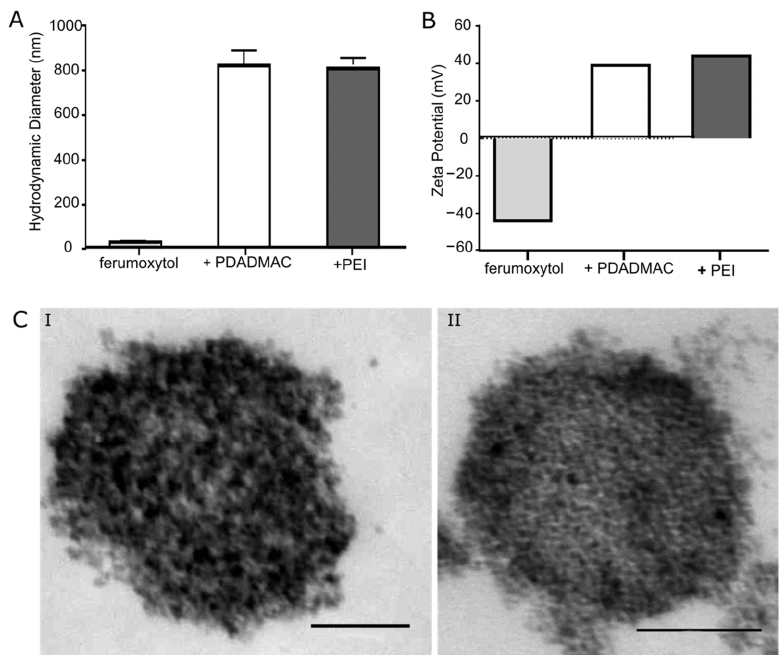
Figure 1. Characterization of uncoated, PDADMAC-, and PEI-coated ferumoxytol MNPs. ( A ) The hydrodynamic diameter of MNPs determined by DLS scans. ( B ) Surface charges (zeta potential) of MNPs obtained by Zetasizer measurements. ( C ) TEM images of ( I ) PDADMAC-coated ferumoxytol and ( II ) PEI-coated ferumoxytol clusters. Scale bars, 100 nm.